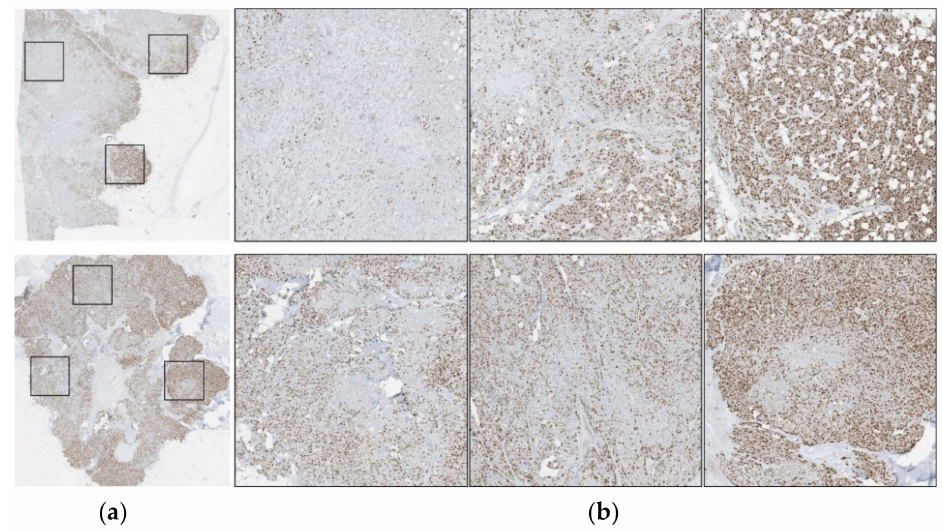
Figure 3. Variability of a WSI can be displayed in ( a ) W SI images, with corresponding ( b ) candidate regions for